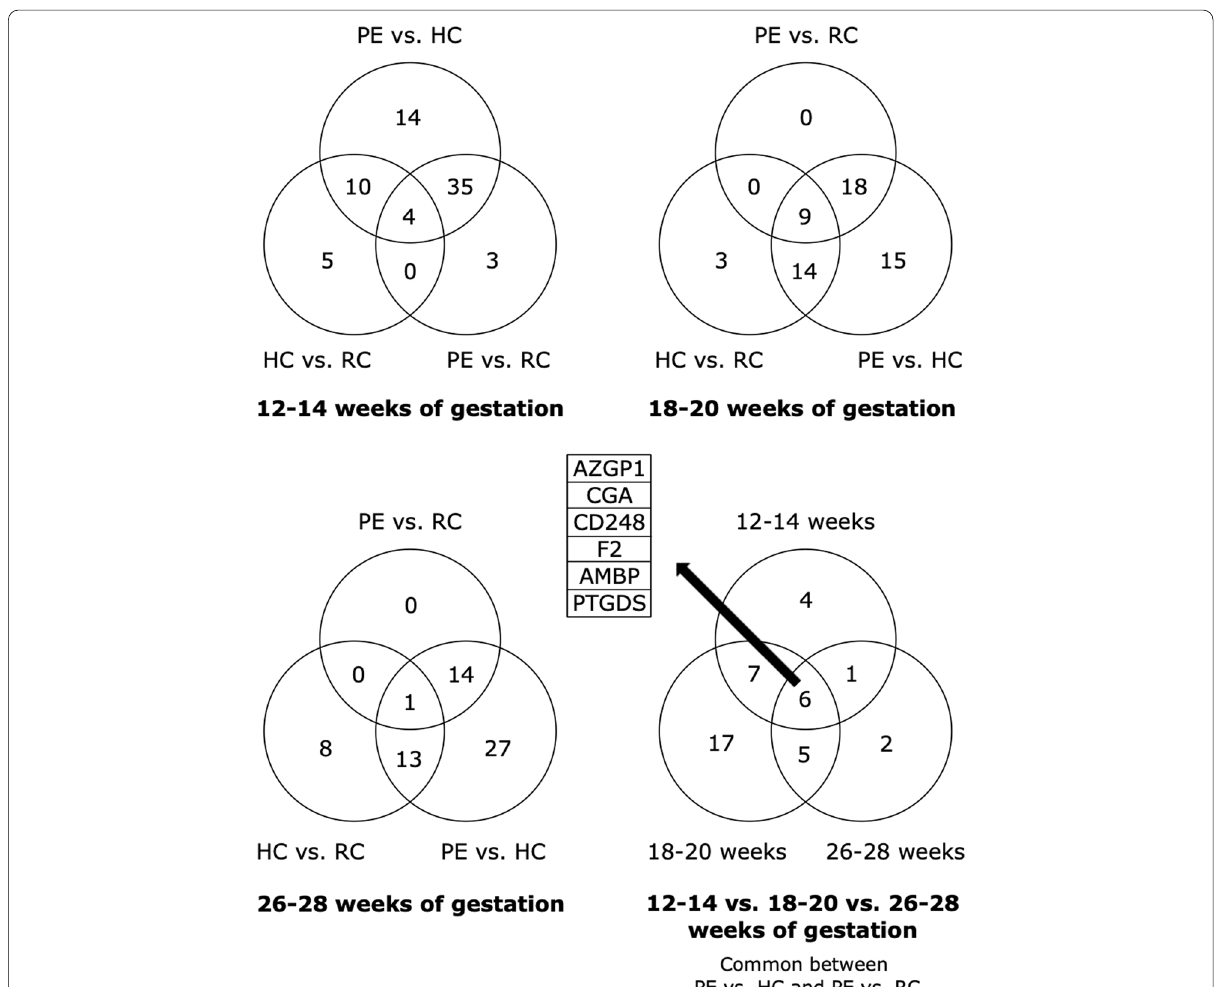
Fig. 3 Venn diagrams comparing proteins with VIP values > 1. These proteins were compared between the binary comparisons PE vs. HC, PE vs. RC, and HC vs. RC. All comparisons were done separately according to sampling time point (12–14, 18–20, and 26–28 weeks of gestation). Finally, proteins overlapping between the comparisons PE vs. HC and PE vs. RC in all time points were compared to each other, leading to the identification of six proteins that were able to separate HC and RC from PE at all sampling time points. The gene names of these six proteins are shown in the center of the figure. VIP variable influence on projections, PE preeclampsia, HC healthy controls, RC risk controls = = = =